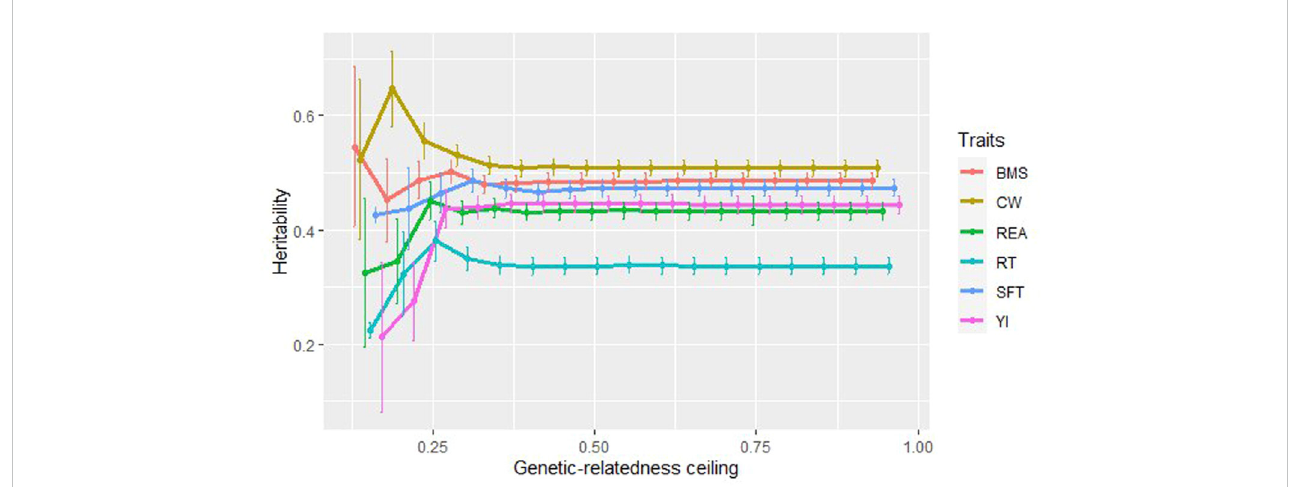
FIGURE 3 The estimated heritability for carcass traits at the different degrees of genetic-relatedness ceiling.